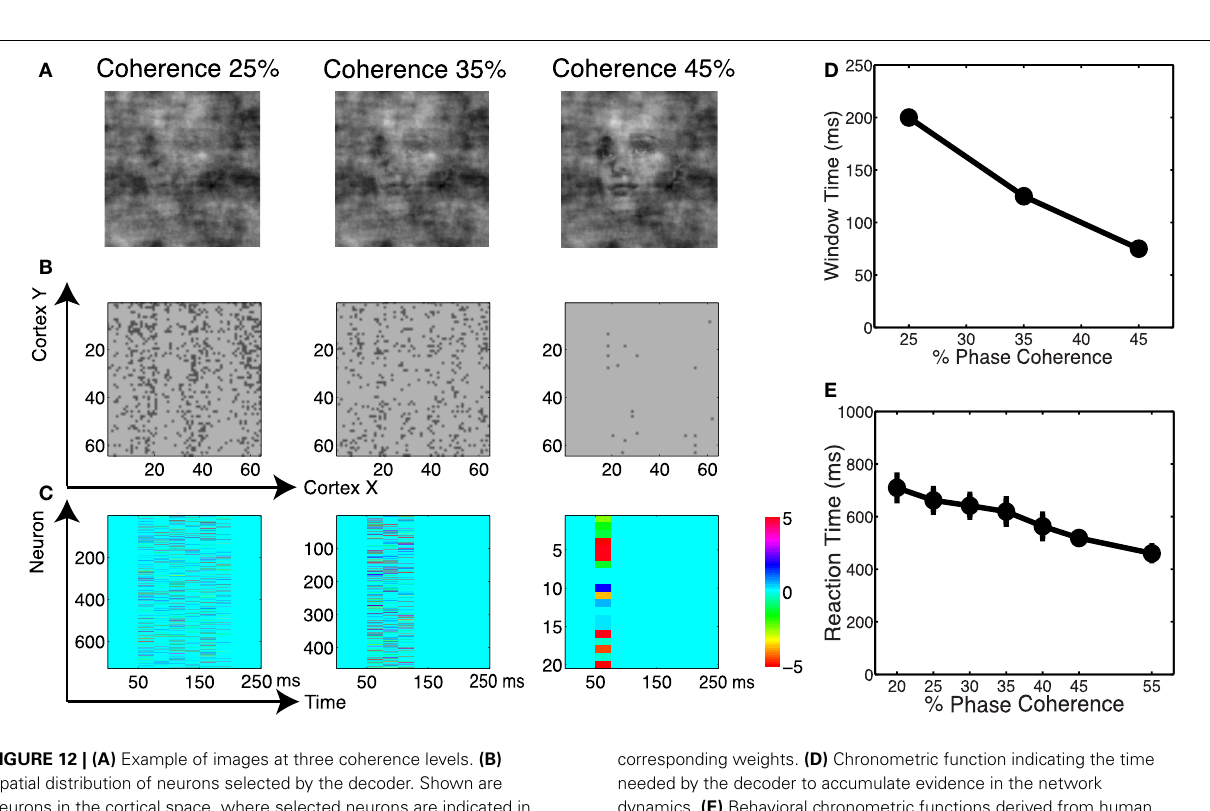
corresponding weights. (D) Chronometric function indicating the time needed by the decoder to accumulate evidence in the network dynamics. (E) Behavioral chronometric functions derived from human